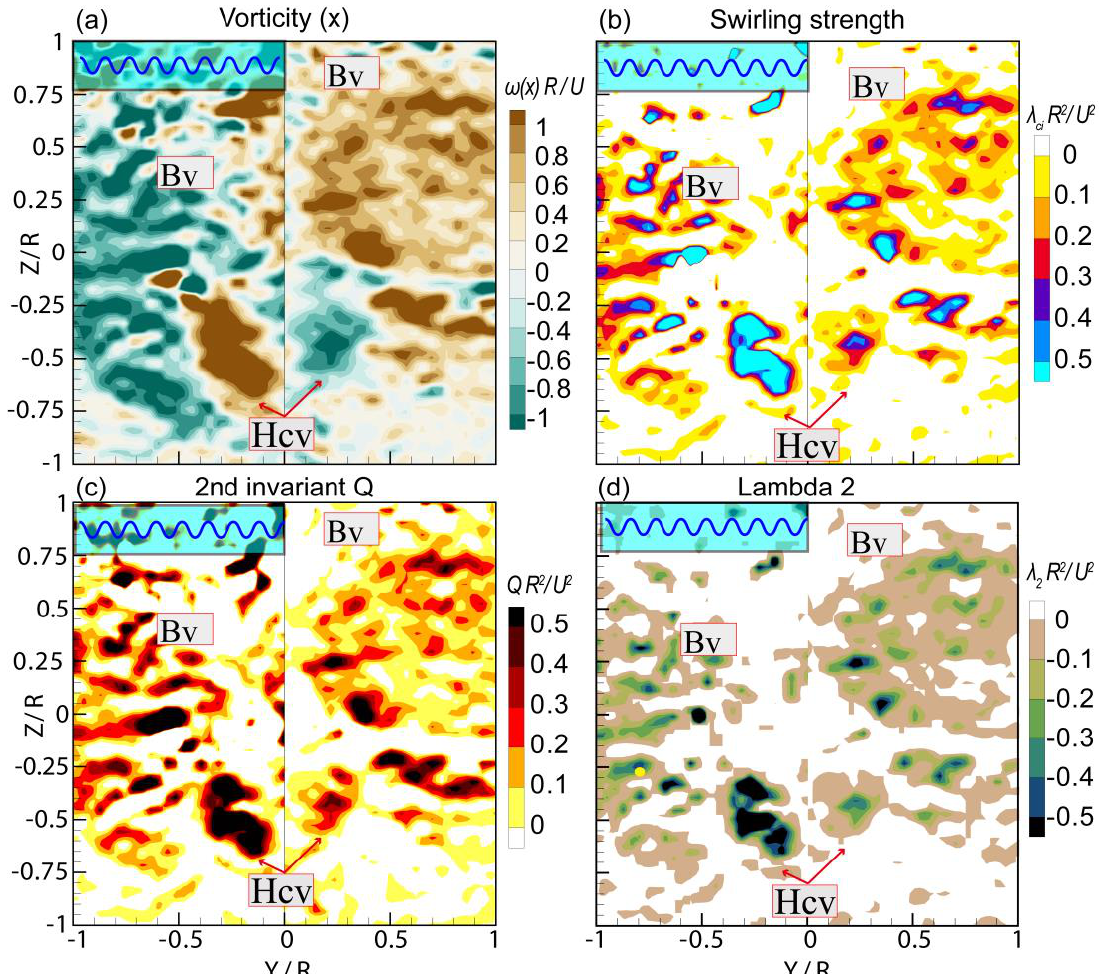
Figure 13. Time-averaged vorticity information in the propeller region: Left . The ballast condition; Right . The design condition. ( a ) Contour maps of the vorticity; ( b ) Contour maps of the swirling strength; ( c ) Contour maps of the planar 2nd invariant; ( d ) Contour maps of the lambda 2